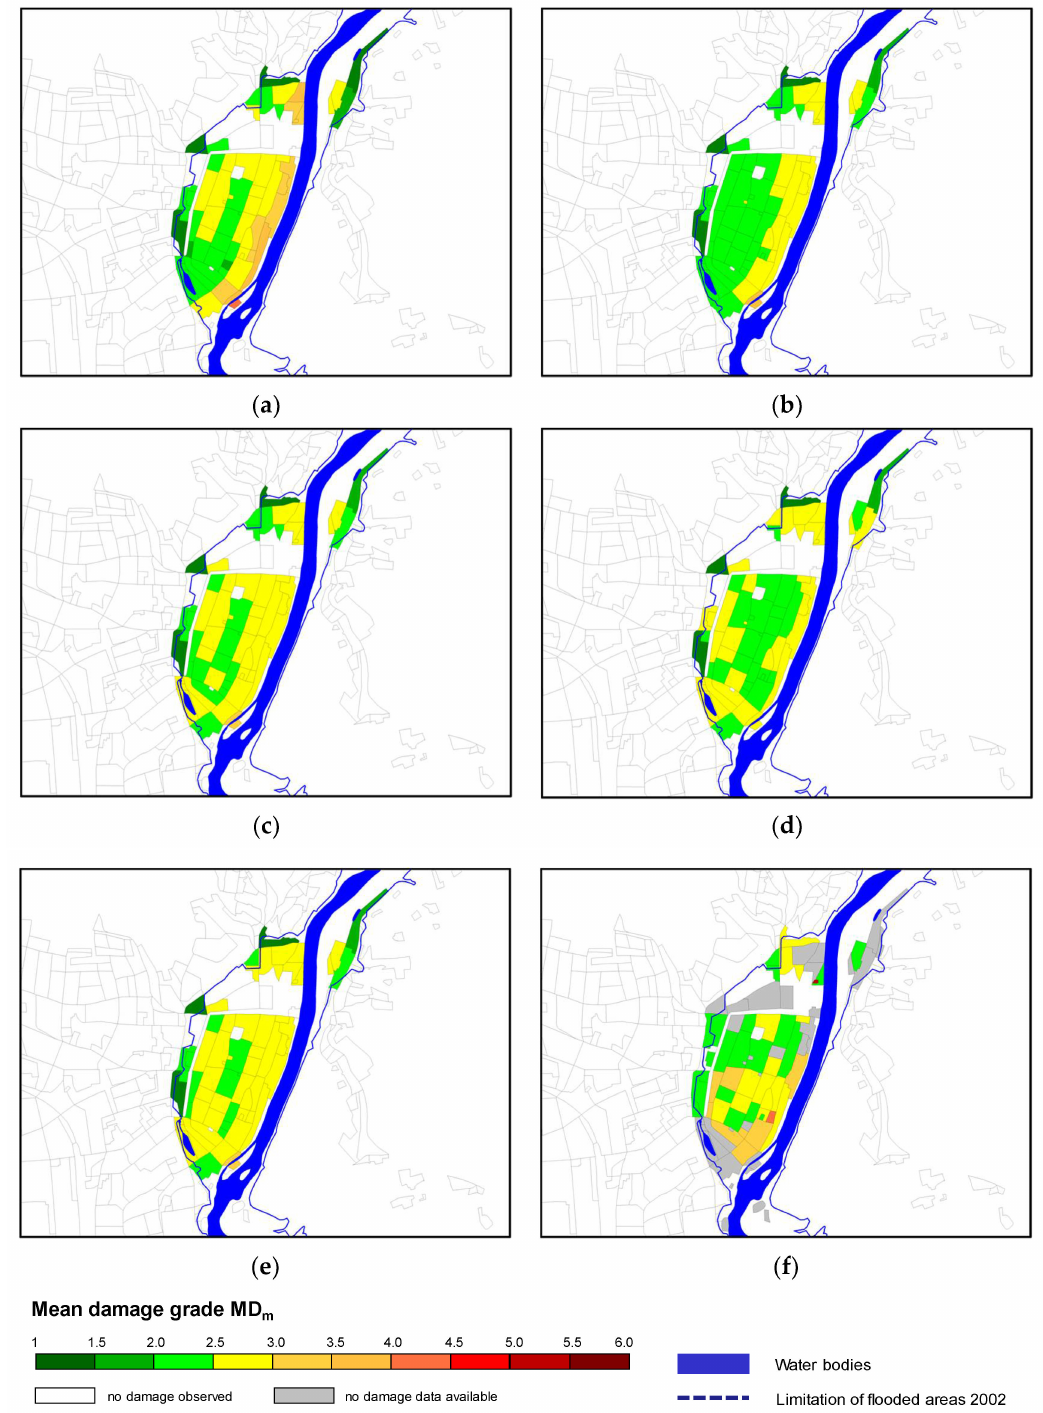
Figure 10. Comparison of the calculated mean damage grades MD m,calc in the land-use areas (micro- scale damage calculation) and the observed damages ( MD m,obs ) in Grimma (Level 2): ( a ) variant V1; ( b ) variant V2; ( c ) variant V3; ( d ) variant V4; ( e ) variant V5; ( f ) observed